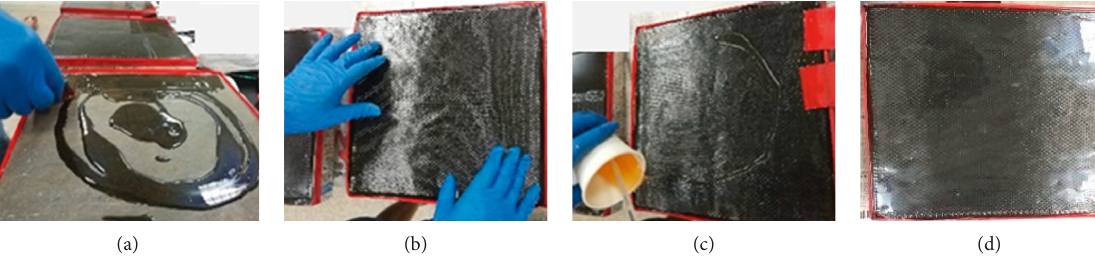
Figure 5: Specimen preparation of fiber-reinforced resin composite overlay: (a) blade coating resin on the bottom; (b) laying fiber cloth; (c) brush coating resin on the surface; (d) curing.